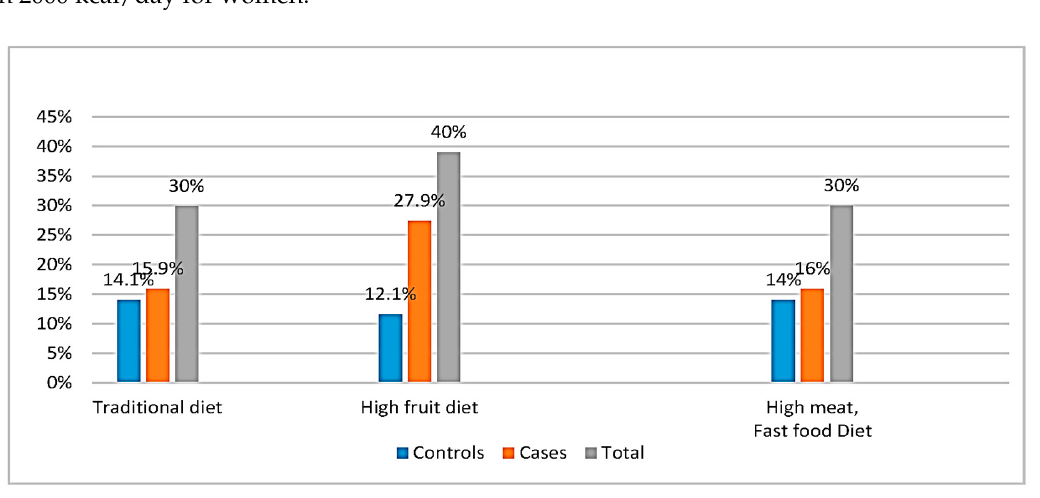
Figure 2. Distribution of participants according to the different dietary patterns. Table 6. Odds ratios and 95% confidence intervals for the association between dietary patterns and the odds of NAFLD in the study